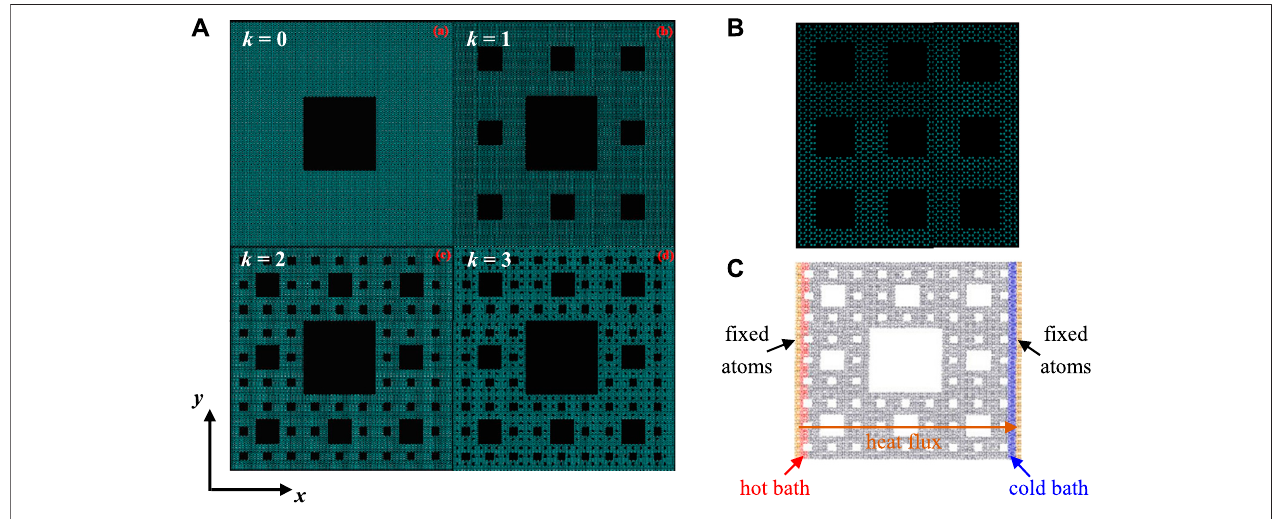
FIGURE 1 | Schematic of heat transfer in defective graphene: (A) SCF defects; (B) RC defects; and (C) thermal boundary condition.